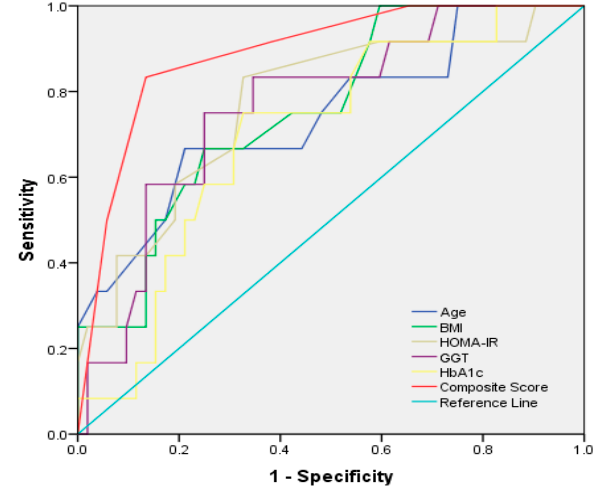
Figure 1. Receiver operating characteristic (ROC) curves for GGT, AGE, BMI, HOMA-IR, HbA1c, and composite score for the detection of F3/F4 group of patients.